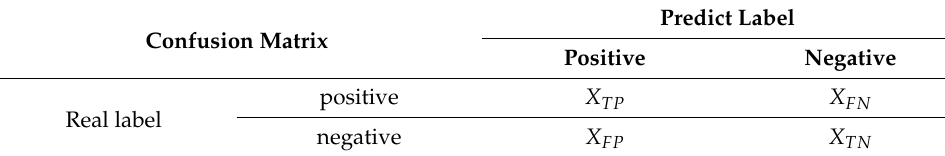
Table 2. The distribution of classification results.